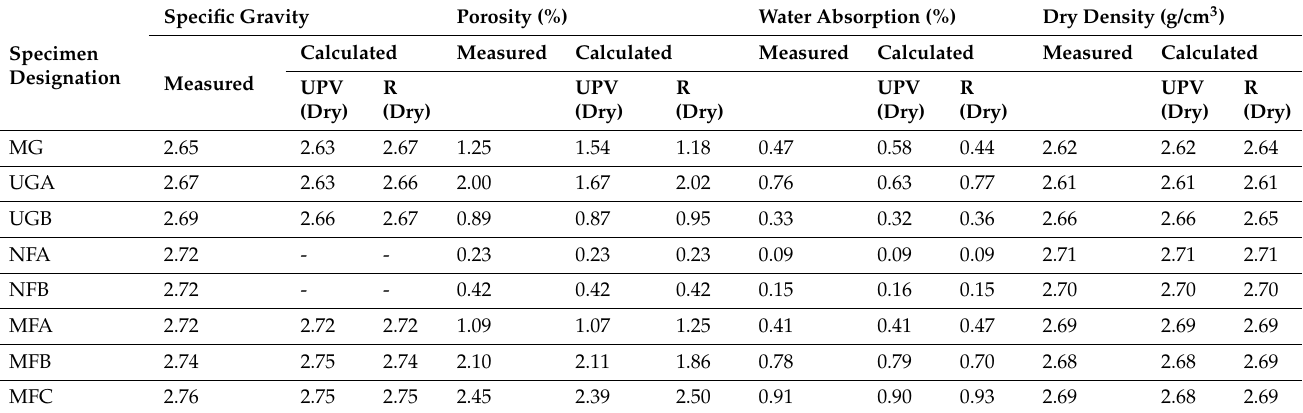
Table 6. Measured and calculated values of physical properties.